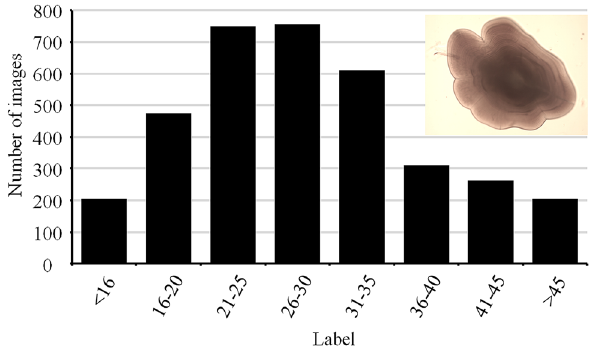
Figure 6. Distribution of the labels (i.e., number of post-settlement rings) of all images in the otolith dataset ( n = 3585